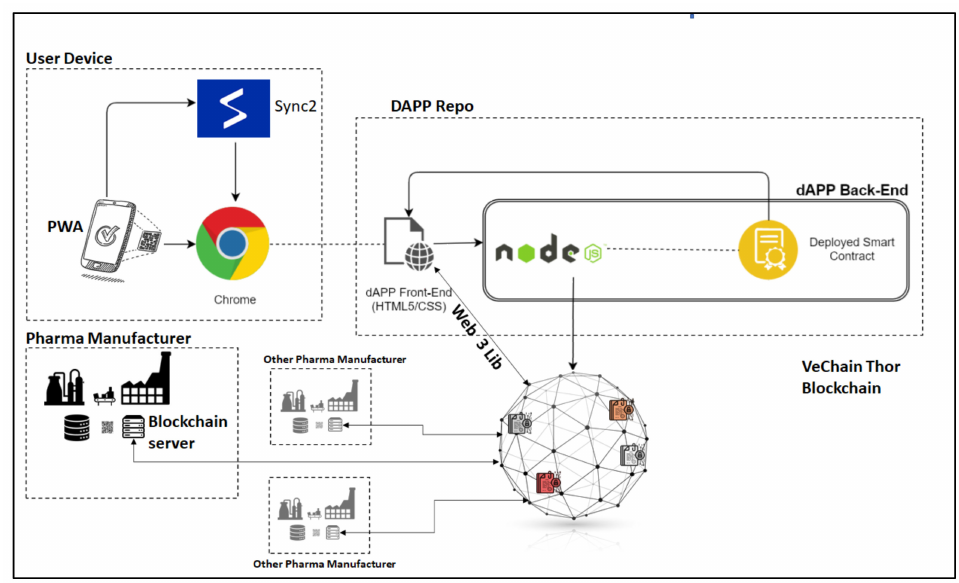
Figure 12. High-level SW/HW Infrastructure of the NFT Track & Trace